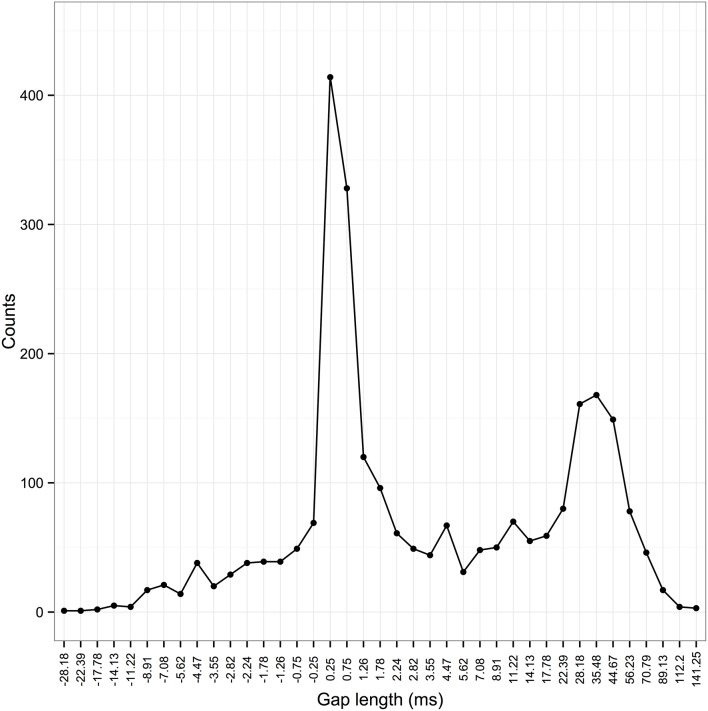
Frequency distribution of inter-element gaps in zebra finch songs. The x-axis shows the length of inter-element gaps. Since zebra finch elements can overlap in time, negative gaps are possible [when start time element 2 (st2) < end time element 1 (et1), st2 −et1 is negative]. Elements are grouped into bins with an approximately logarithmic scale (direction reversed for values < 0; bin sizes of 0.5 ms between −1 and 1 ms due to limits in measurements from the spectrogram). Temporal features of acoustic signals appear to be perceived on a logarithmic scale by birds (Dooling and Haskell, 1978).